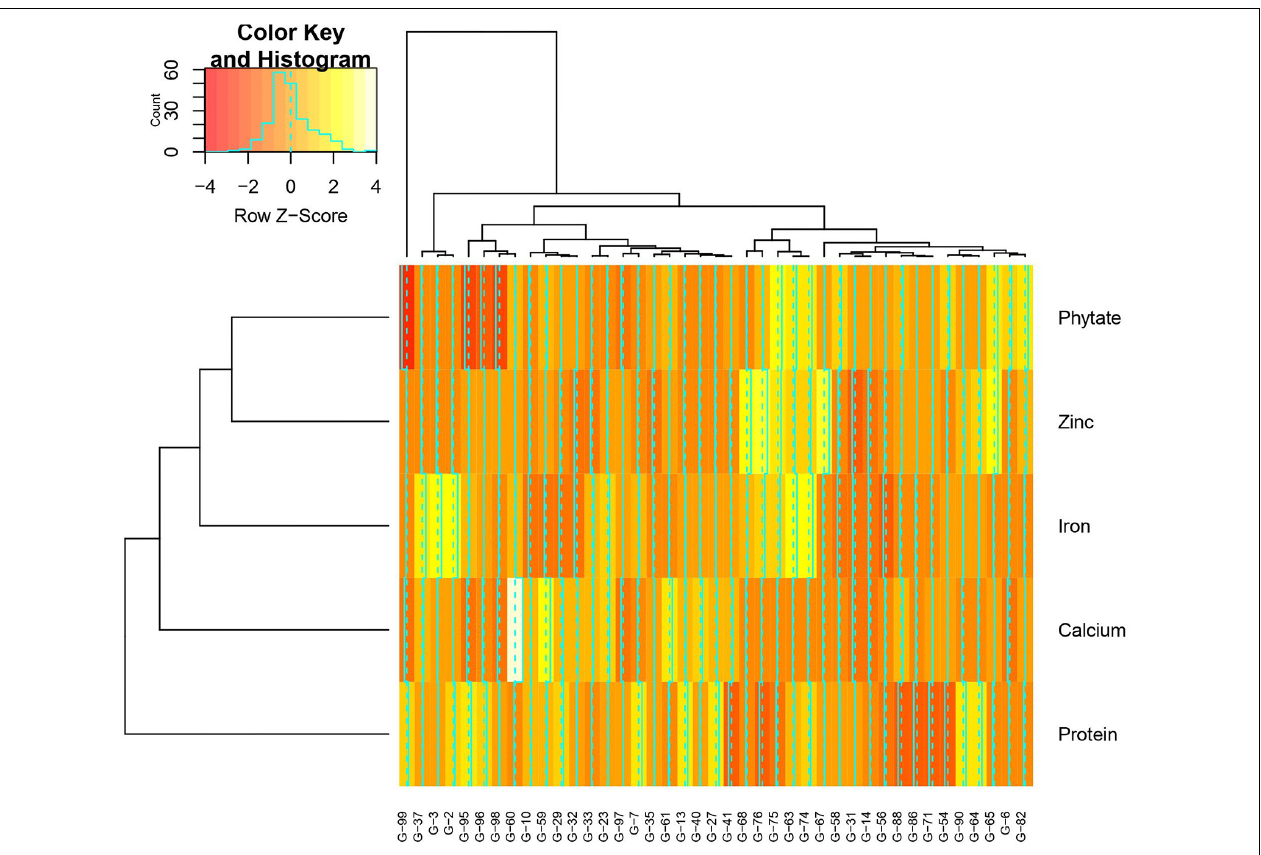
FIGURE 5 | Hierarchical cluster analysis showing the relationship between the 5 highest and 5 lowest accessions of Vigna stipulacea for Fe, Zn, Ca, protein, and phytate over two locations (Loc1 – ICAR-IIPR, Kanpur, and Loc2 – ICAR-NBPGR, New Delhi). All together 41 accessions were considered for these five parameters. Numbers correspond to accessions as listed in Table 1